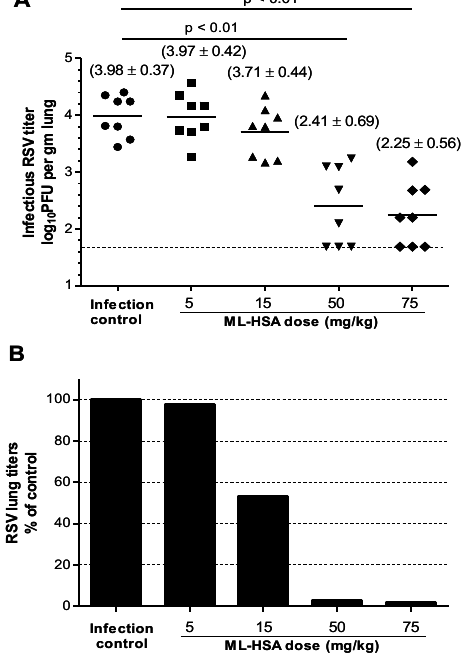
Figure 8. Inhibitory activity of ML-HSA on in vivo RSV infection in BALB/c mice. ( A ) ML-HSA at different concentrations was mixed with the RSV Long Strain before intranasal inoculation. The infectious RSV titer in the mouse lung was expressed as the log10 PFU per gram of lung tissue. Each data point represents the RSV titer for each individual animal in the respective treatment cohort. The horizontal line, drawn in each cohort, marks the geometric mean RSV titer of the group. The horizontal hatched line, across the graph, represents the RSV titer at the limit of assay detection. ( B ) Percentages of viral titer (geometric mean) in the lungs of ML-HSA - treated cohorts relative to infection control group (without ML-HSA